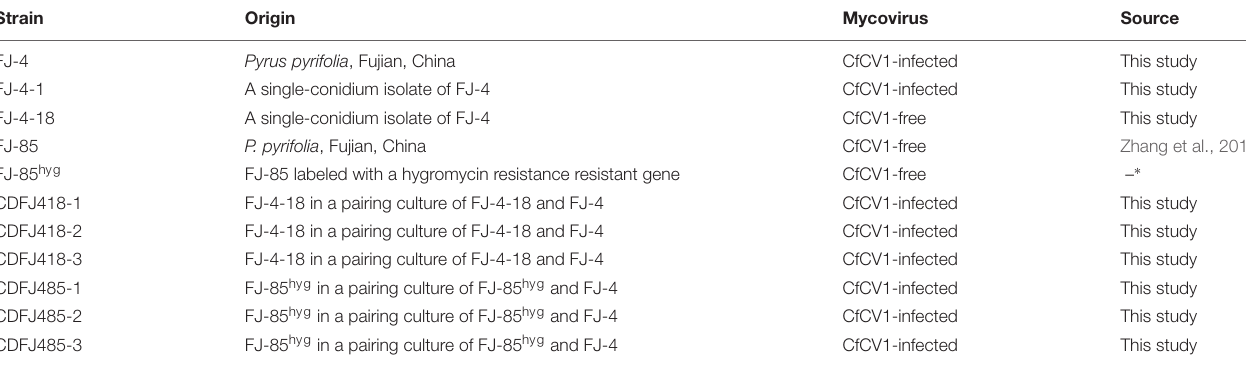
TABLE 1 | Origin of strains of Colletotrichum fructicola used in this